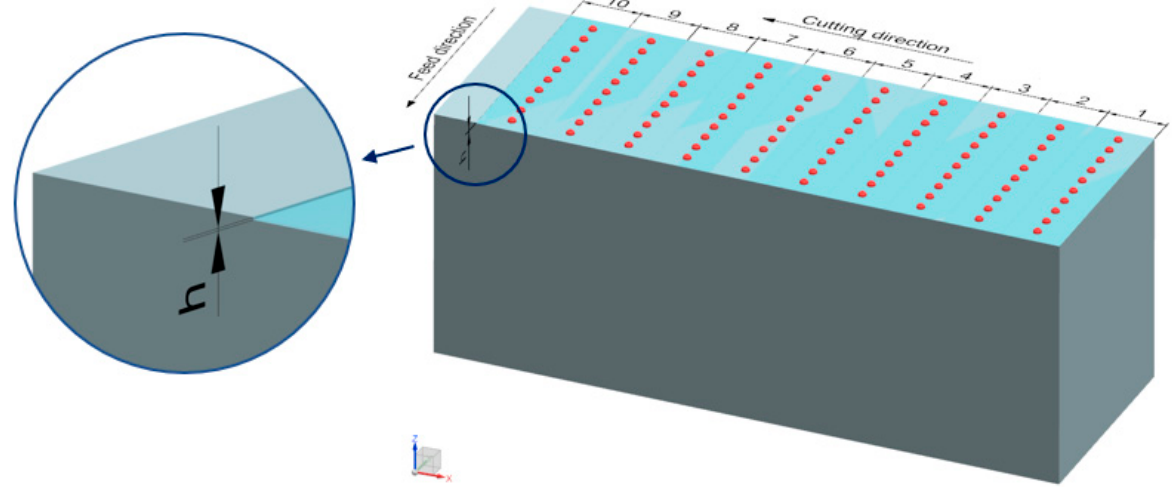
Table 2. Plan of experiments and tested values of technological parameters.